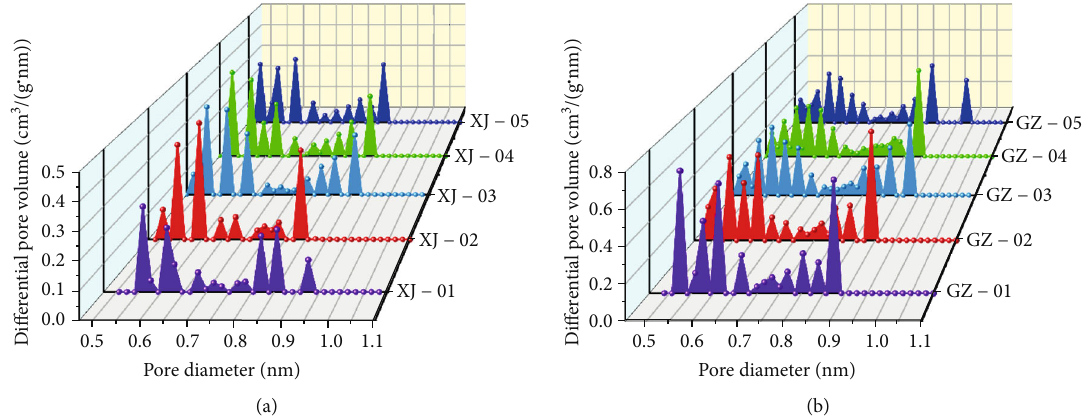
Figure 8: Pore size distributions of microp ores in the coal samples with di ff erent particle sizes. (a) Coal XJ (XJ-01 to XJ-05 represent Coal XJ with particle size from 0.5-1.0mm to 0.032-0.063mm). (b) Coal GZ (GZ-01 to GZ-05 represent Coal GZ with particle size from 0.5-